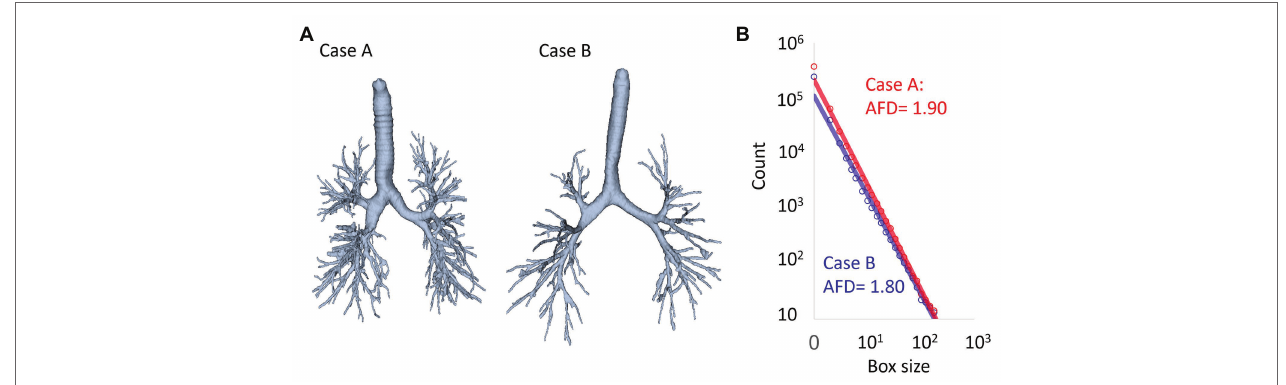
FIGURE 5 | Fractal analysis of airway trees on CT based on the box-counting method. (A) Examples of segmented airway trees in two cases. (B) Using the box-counting method, the number of boxes that included the airway tree was counted. This counting was repeated for different box sizes. The count of boxes including the airway trees was plotted on a double logarithmic graph and the airway FD (AFD) was calculated as the negative slope of the regression lines (AFD = 1.90 and 1.80 for cases A and